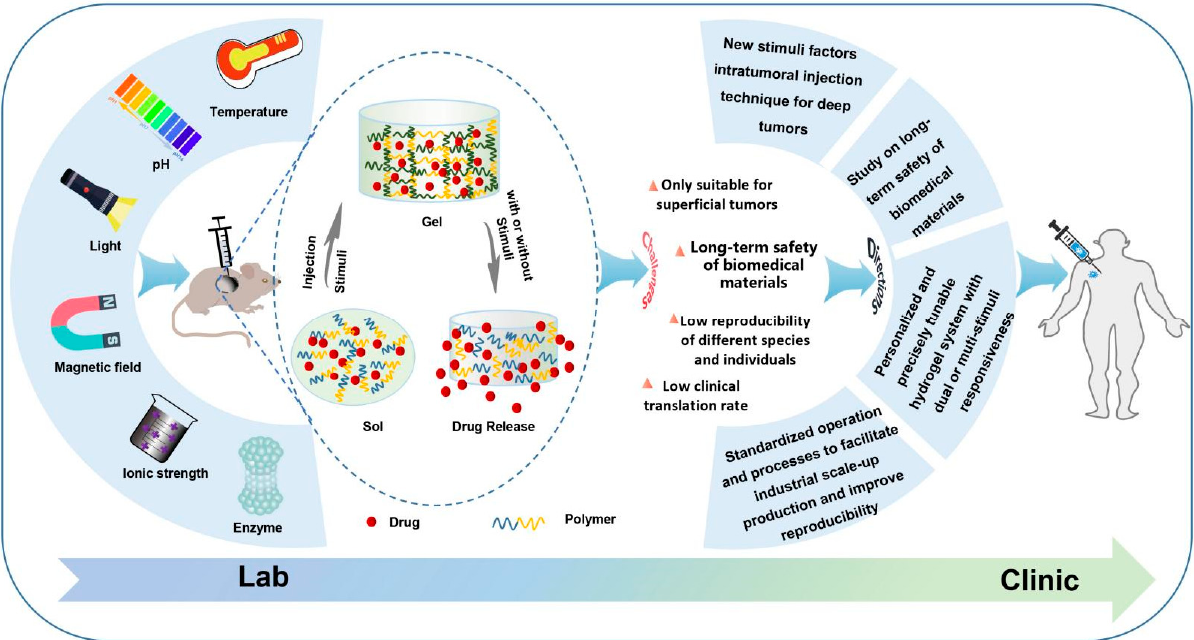
Figure 1. Schematic formation process and drug release of in situ smart hydrogel and challenges and future directions.